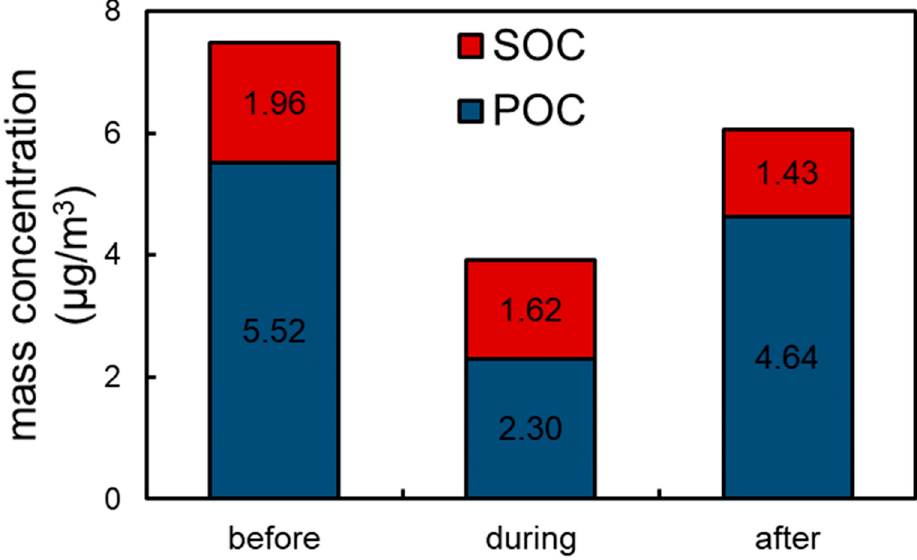
Figure 5. Concentration of SOC and POC in 3 periods. The average concentrations are marked inside the columns.